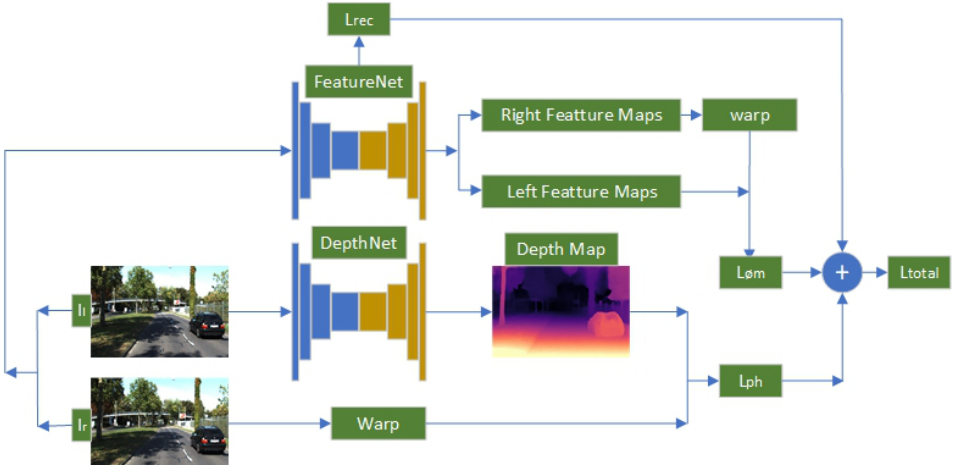
Figure 1. The architecture of our monocular depth estimation model. The blue part of DepthNet in Figure 1 indicates that the encoder of the depth estimation backbone network. The yellow part means decoder. We input the target image into our backbone network to obtain the point-by-point depth map. The feature maps are obtained from the FeatureNet. We use the source image and the lowest-level source feature map combined with the depth map to generate the reconstructed target image and the reconstructed target feature map. The training is jointly supervised by calculating L ph , L φ m , L s and L rec